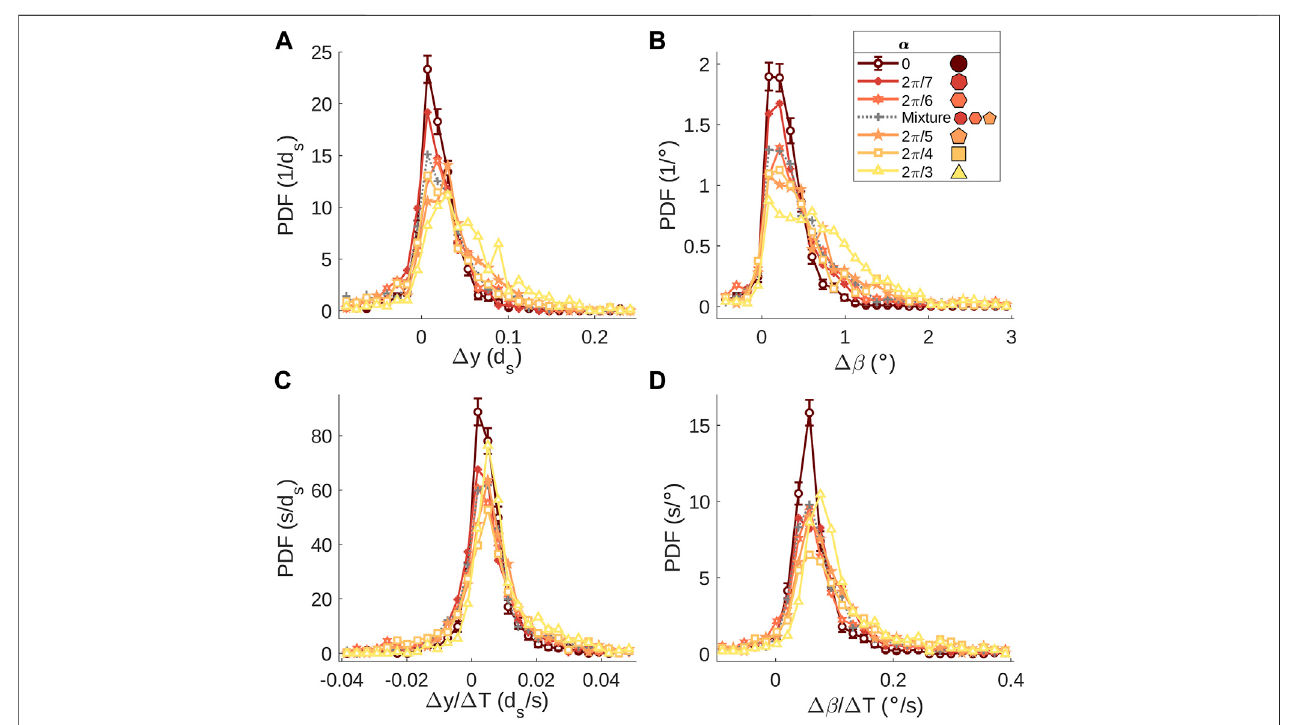
tends to rotate the slider about a pivot point that is located near the sloped front end; y and β increase as a result. Figures 8A,B displays PDFs of Δ y and Δ β , the changes in the vertical position (as de fi ned in Figure 1 ) and angle of the slider from the beginning to end of sticking periods. With increasing angularity, both PDFs broaden towards larger values.